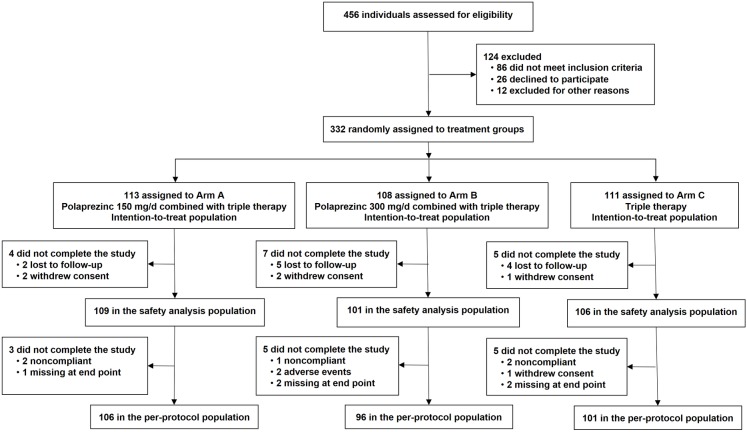
Participant flow.